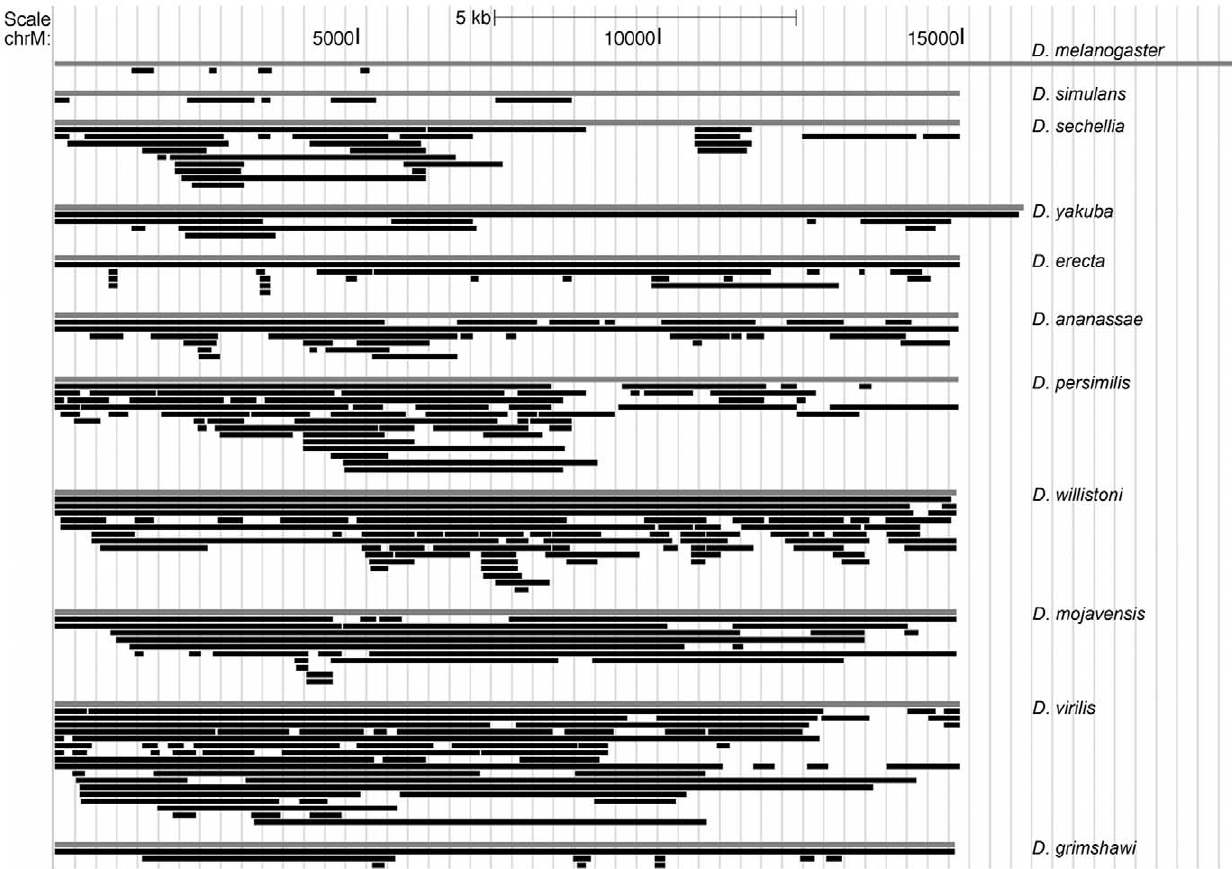
Figure 1. Mitochondrial origins ofnumts. Locations of origin of numt sequences (black)in the mitochondrial genomes (grey)for 11 Drosophila species are shown. The D. melanogaster mitochondrial assembly is relatively large, because it has a larger portion of the variable control region sequenced.